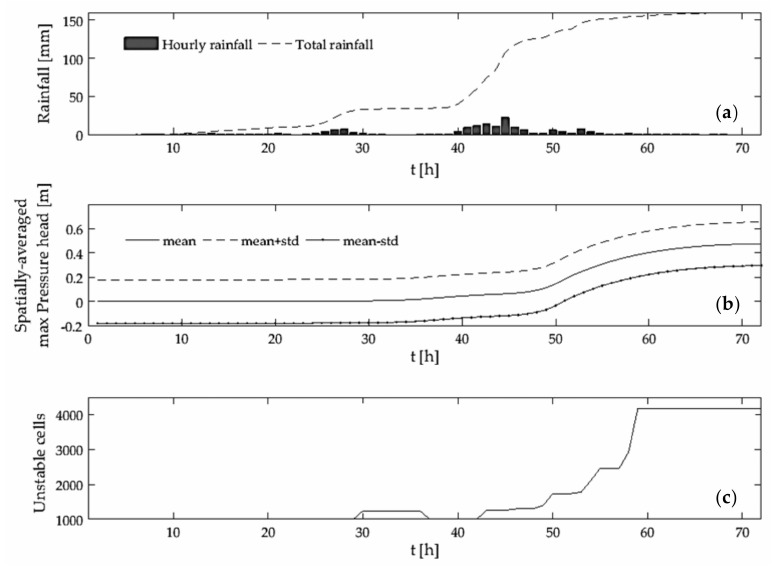
Figure 7. ( a ) Hourly rainfall series used in input for simulations; ( b ) simulated catchment-averaged pressure head series; ( c ) simulated potential unstable cells for the event of 27–28 April 2009 (1D analysis using TRIGRS v. 2.1).